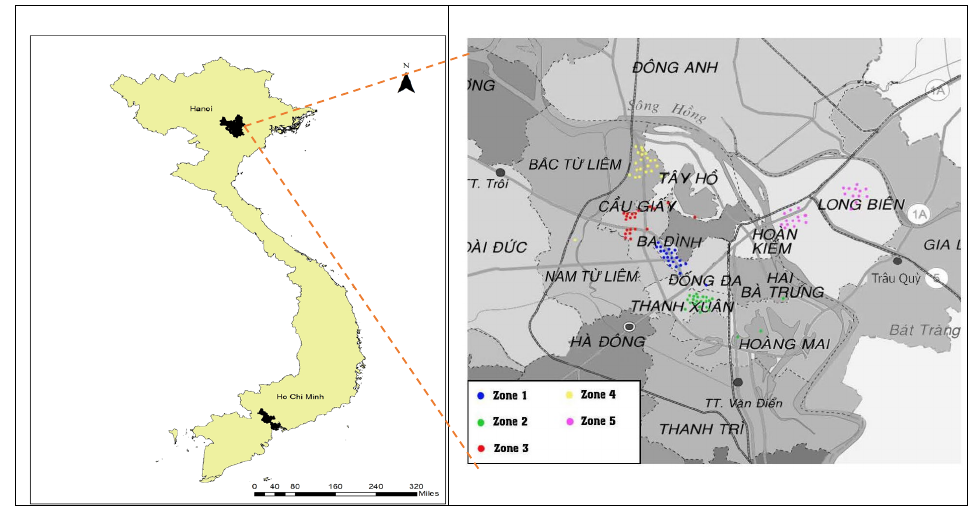
Figure 1. Location of sampling points.